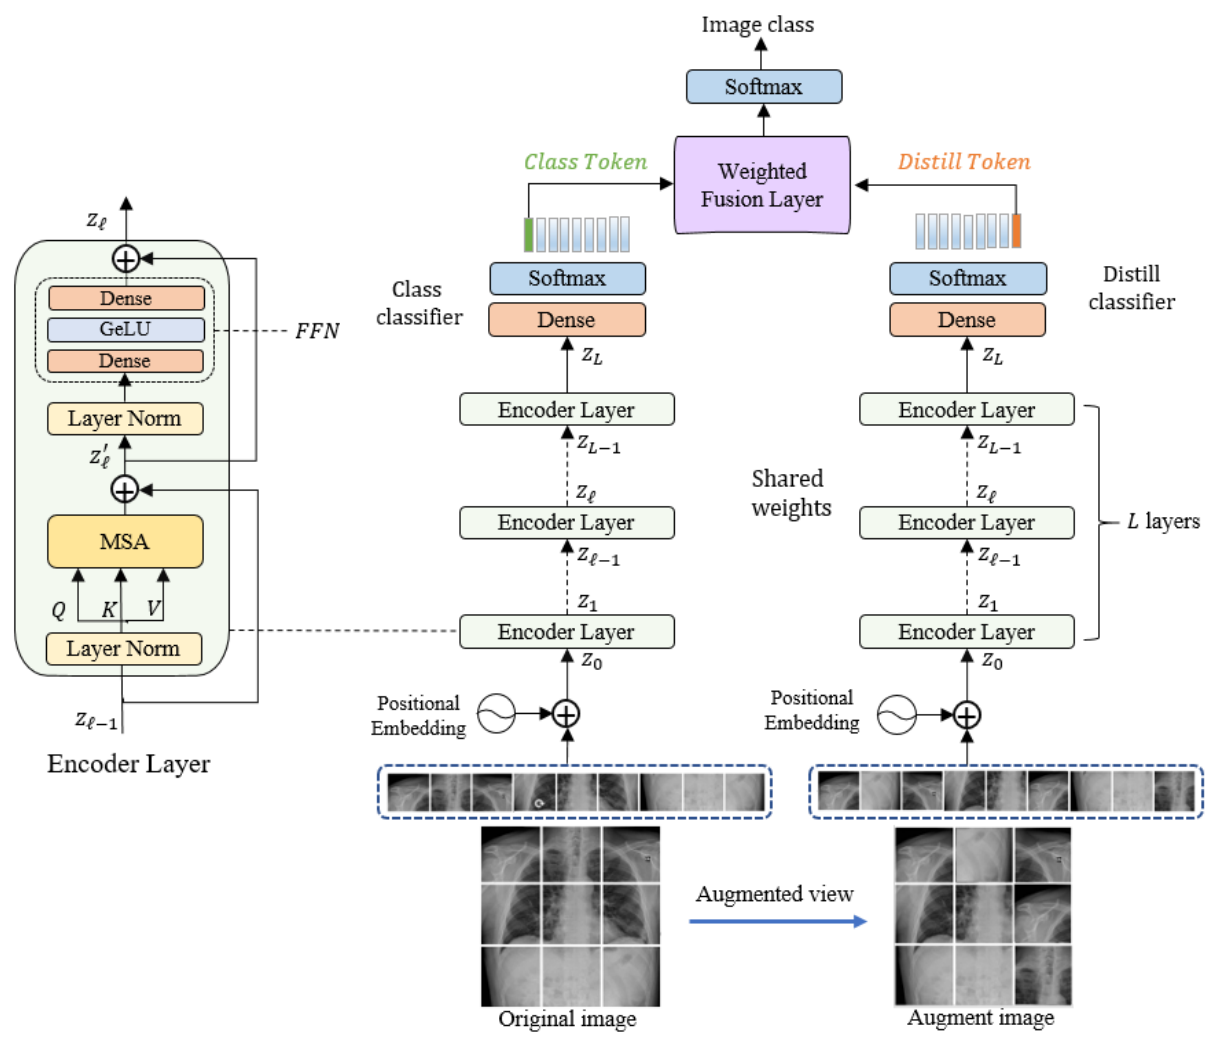
Figure 1. The overall structure of the proposed model.